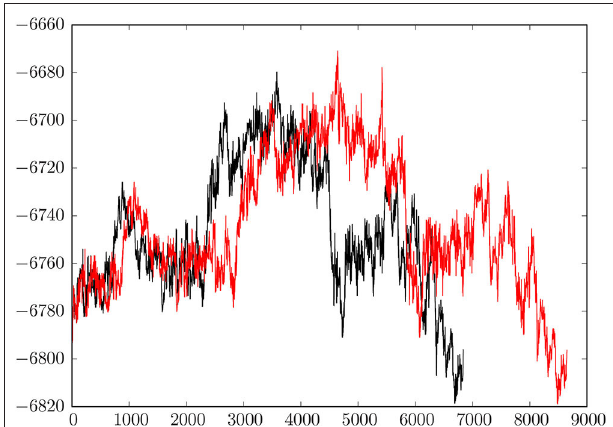
FIGURE 2 | Comparison of the initial connected path and the fastest path after refinement of the database. The relative energy in kcal/mol is plotted against the number of stationary points, which are organized in a connected sequence minimum-transition state-minimum-transition state-minimum, etc. from pre- to post-fusion structures. The initial path has 4,326 transition states and 8,653 stationary points; the refined path has 3,420 transition states and 6,841 stationary